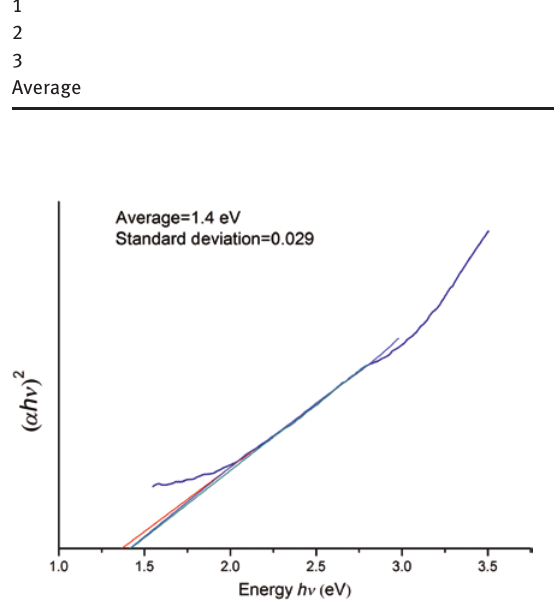
Figure 4: Plot showing the determination of the band-gap energy from diffuse reflectance measurements of the as-synthesized powder.